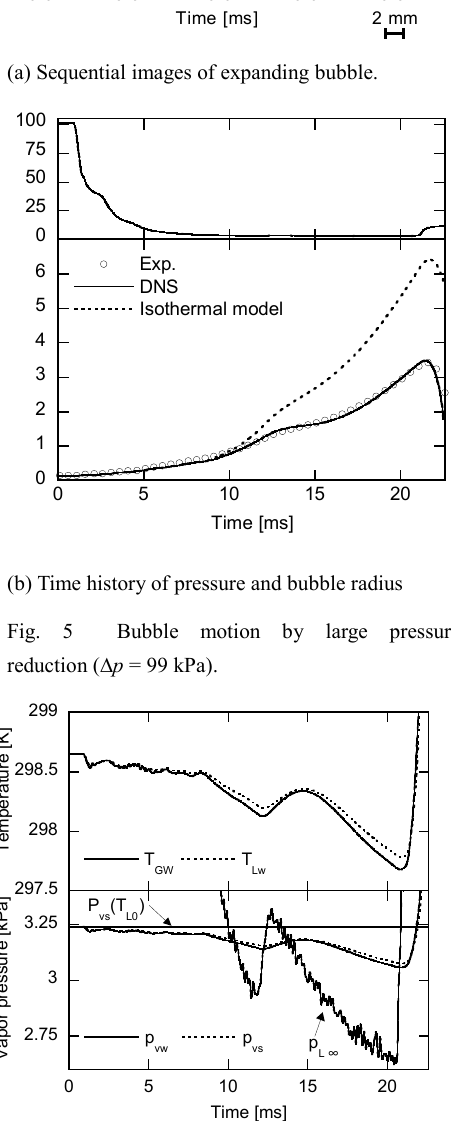
Fig. 6 Time history of wall temperature and vapor pressure for Fig.